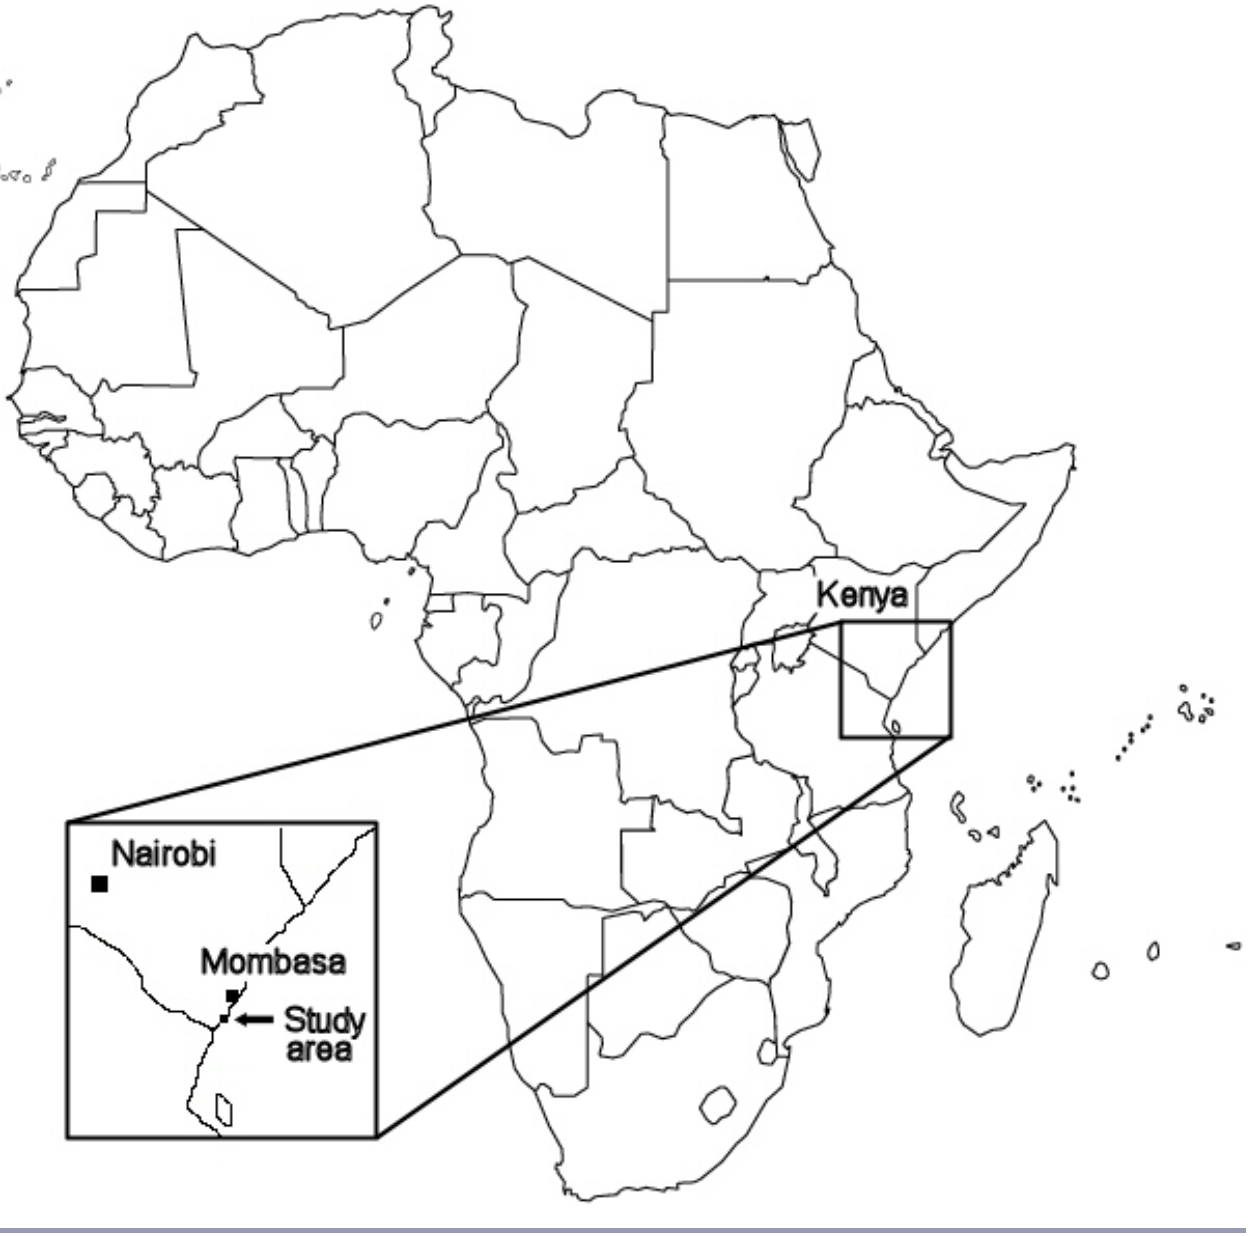
Fig. 1 . Map of the study area with the target community indicated in the inset of the left hand corner. The area is located on the southern Kenyan coast at 4°25’S and 39°50’E, approximately 50 km south of